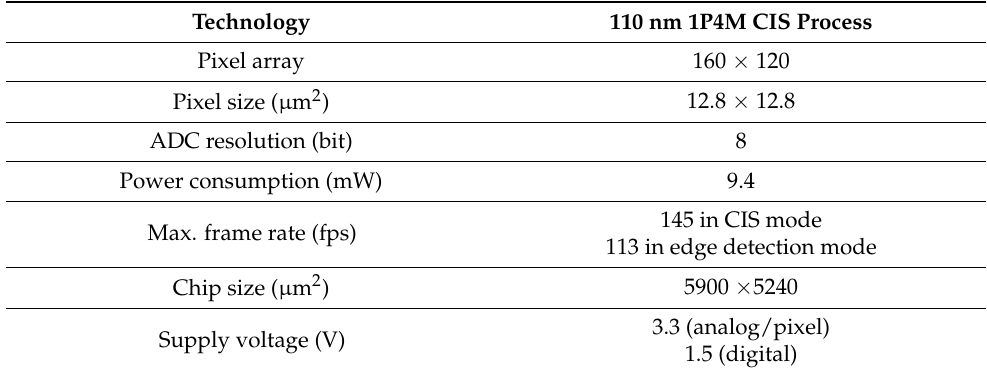
Table 5. Performance characteristics of the proposed edge detection CIS.